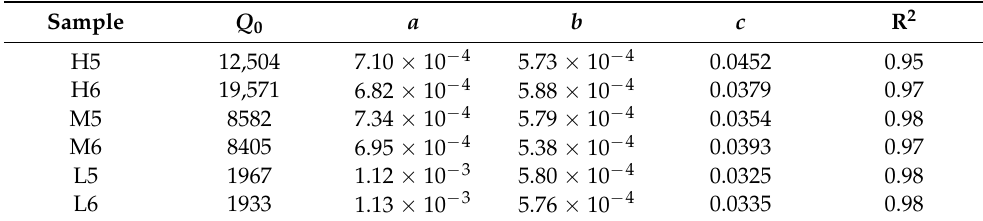
Table 8. Parameter values of Q-factor degradation fitting curve baking at 125 ◦